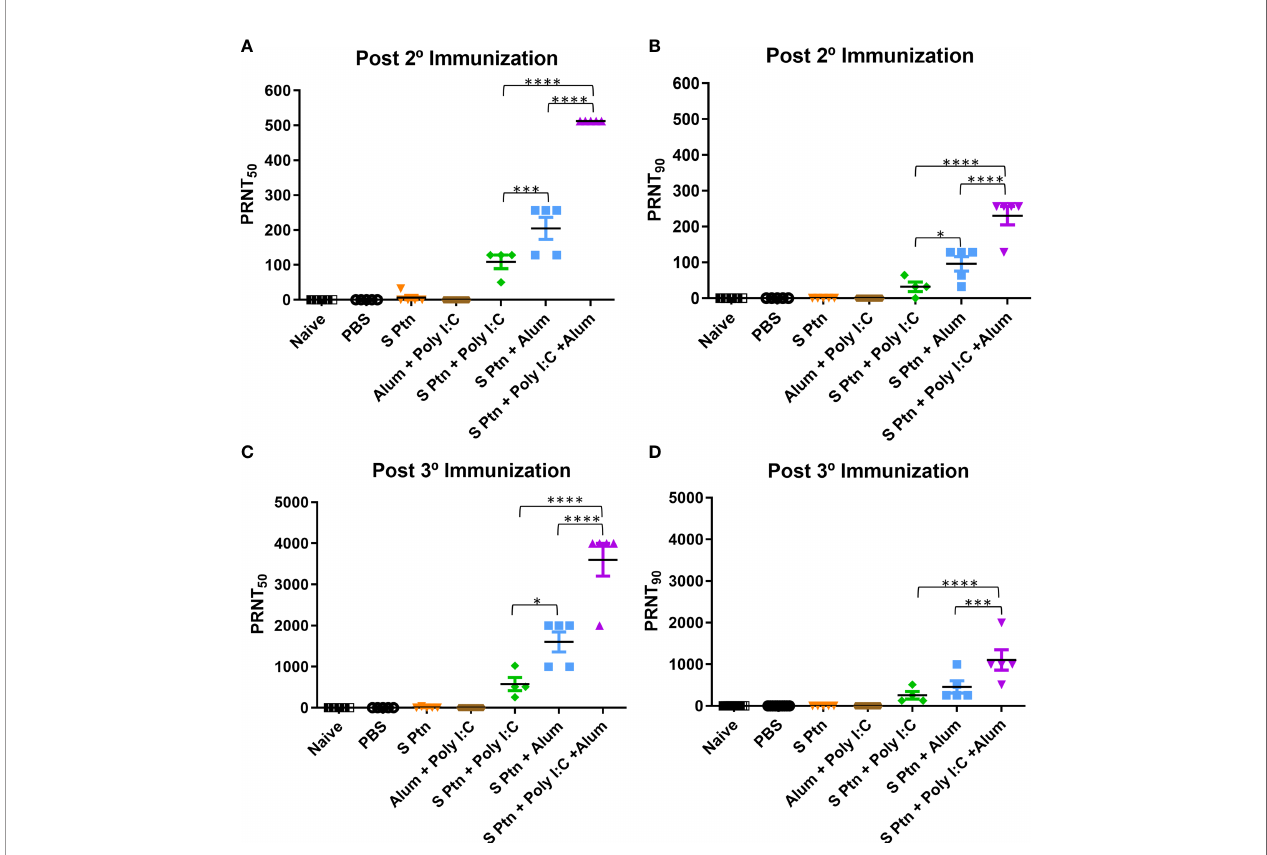
FIGURE 4 | Spike protein associated to Poly(I:C) plus Alum co-administrated induced high titers of neutralizing antibodies. Titers of neutralizing antibodies were determined in vitro by neutralization assay after two and three immunizations. PRNT50 (A, C) and PRNT90 (B, D) for mice plasma collected 7 days after two and three immunization. Figure representative of 4 independent experiments and shown as mean ± S.D. and analyzed by one-way ANOVA with Tukey ’ s post hoc test. *p<0.05, ***p<0.001,